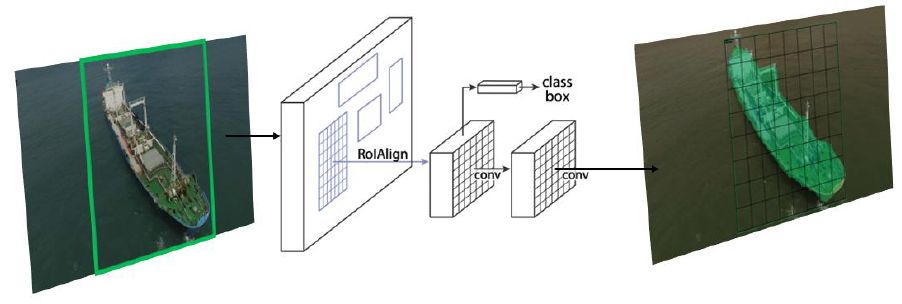
Figure 5. Mask R-CNN